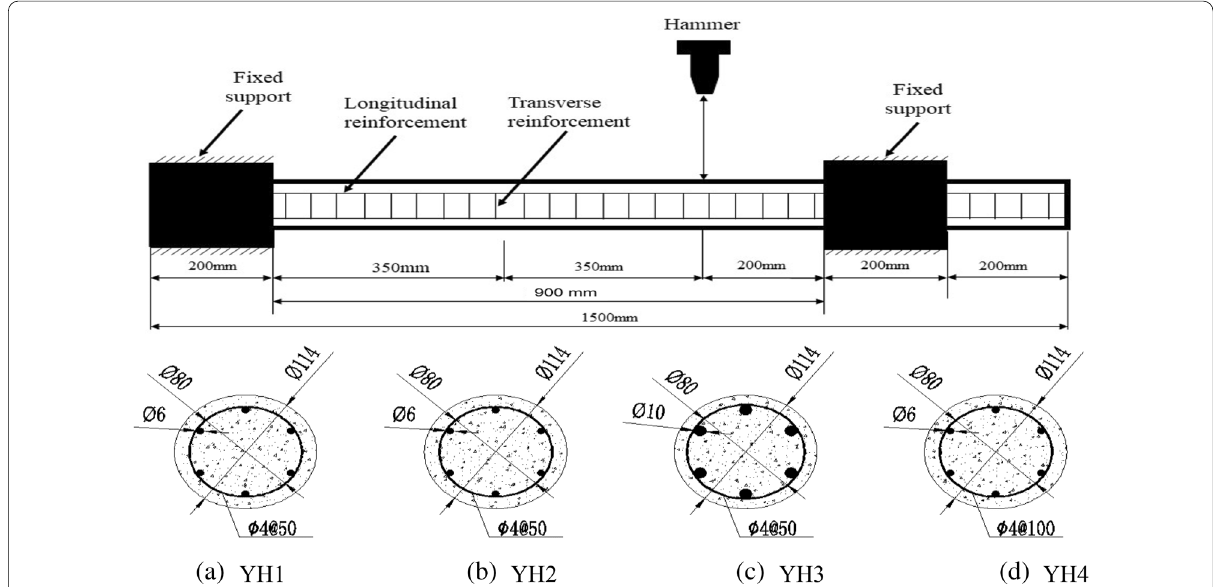
Fig. 2 Dimension and cross‑section of reinforced concrete specimens.